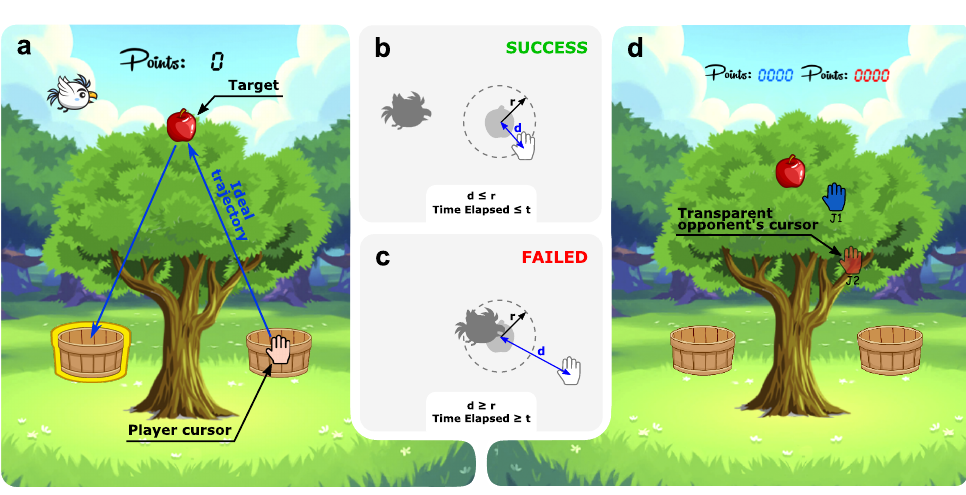
Figure 2. Overview of the game. ( a ) A screenshot of the single-player game mode. ( b ) Condition of successfully reaching the target, where d is the distance of the player cursor to the target, r is the minimum distance to reach the target successfully, and t is the set time to reach the target. ( c ) Condition of failing to reach the target. ( d ) A screenshot of the competitive game